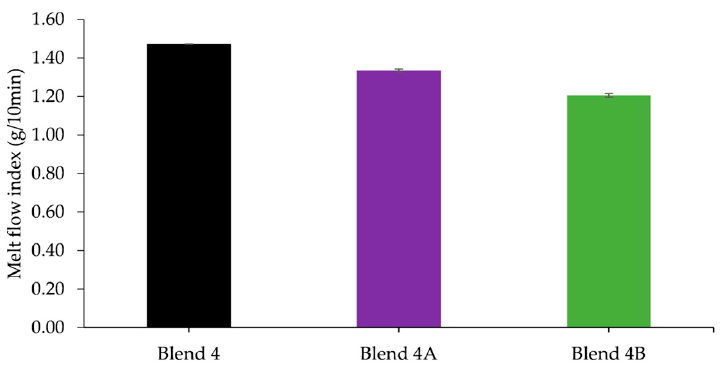
Figure 3. Melt flow index results of nanocomposite batches.